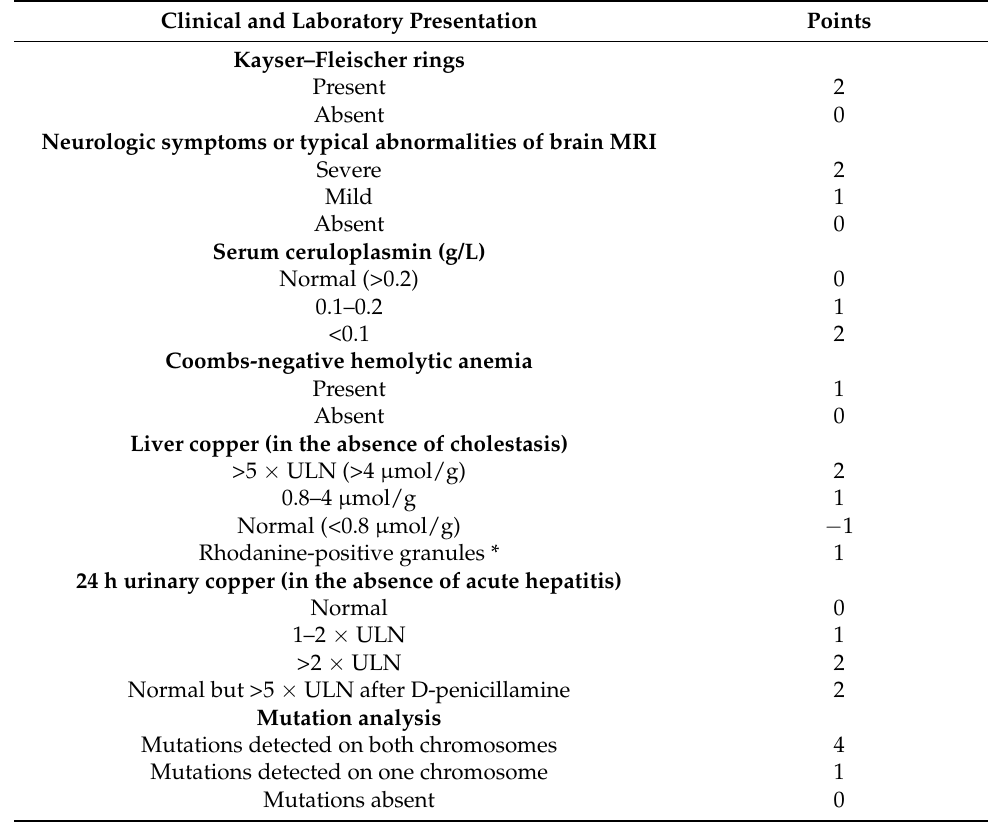
Table 1. Diagnostic scoring system for Wilson’s